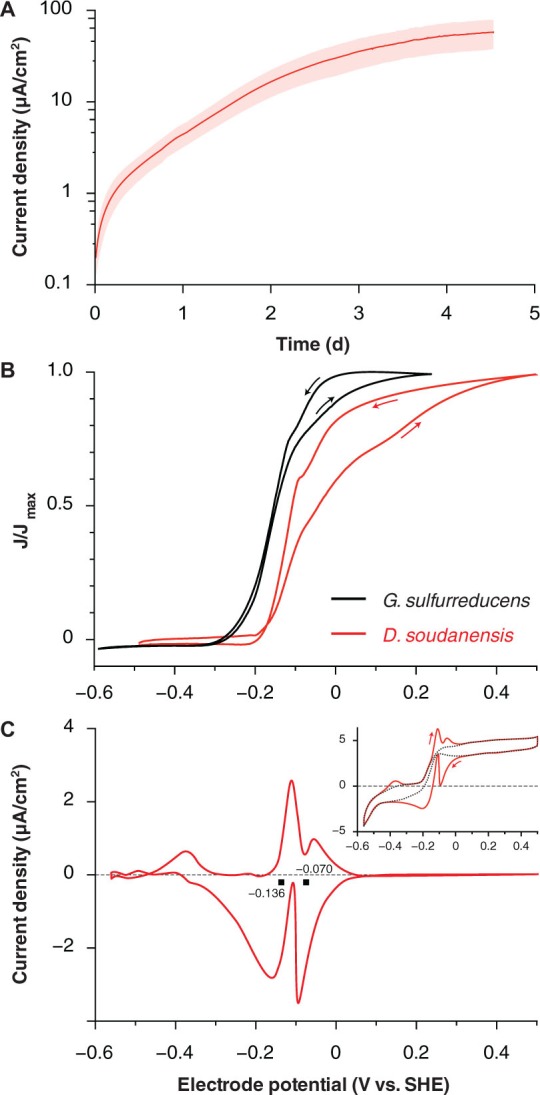
Electrochemical characterization of pure cultures of ‘Desulfuromonas soudanensis’ WTL. (A) Chronoamperometry of potentiostatically controlled acetate-fed 10-ml bioreactors (+0.24 V vs. SHE) containing a single 3 cm2 graphite electrode. All electrode experiments were inoculated 1:2 with late log phase cultures pre-grown under electron acceptor limitation. The red trace and pink area show the mean and standard deviation, respectively, of six independent biological replicates. Estimates of doubling time were calculated against the linear portion of the curve from 0.7 to 2 d. (B) Comparison of low scan rate (1 mV/s) cyclic voltammograms of Geobacter sulfurreducens (Chan et al., 2015; black trace) and ‘D. soudanensis’ WTL (red trace). Current density on the y-axis is normalized against its maximum value for either organism. (C) Baseline subtracted single-turnover cyclic voltammogram of an established ‘D. soudanensis’ biofilm starved of acetate. Black squares denote the midpoint potentials of the two redox processes observed, and the inset shows the raw data (red trace) and polynomial function (black trace) used for baseline subtraction.